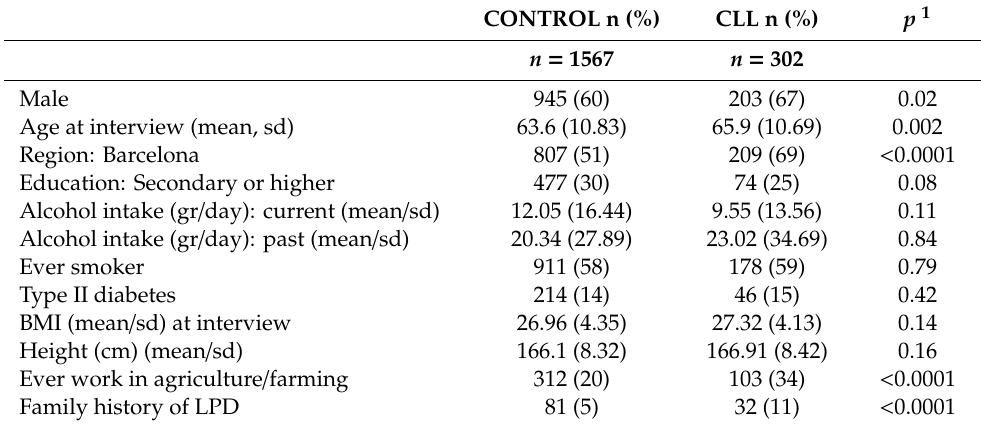
Table 1. Characteristics of controls and chronic lymphocytic leukemia (CLL)